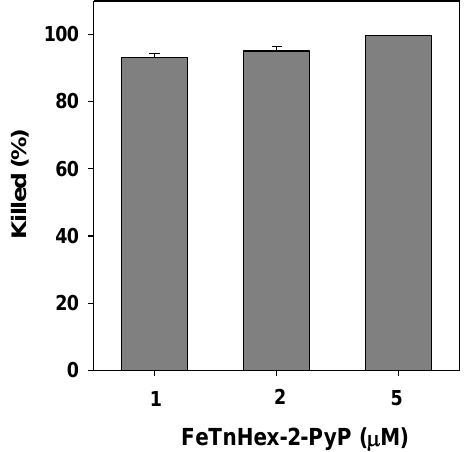
Figure 8. Sensitivity of S. aureus to FeTnHex-2-PyP toxicity. S. aureus (ATCC25923 strain) suspensions in PBS-glucose were incubated two hours with FeTnHex-2-PyP at 37 °C and 200 rpm. At the end of the incubation period, aliquots were properly diluted and plated for counting colonies. Results are presented as mean ± SD.